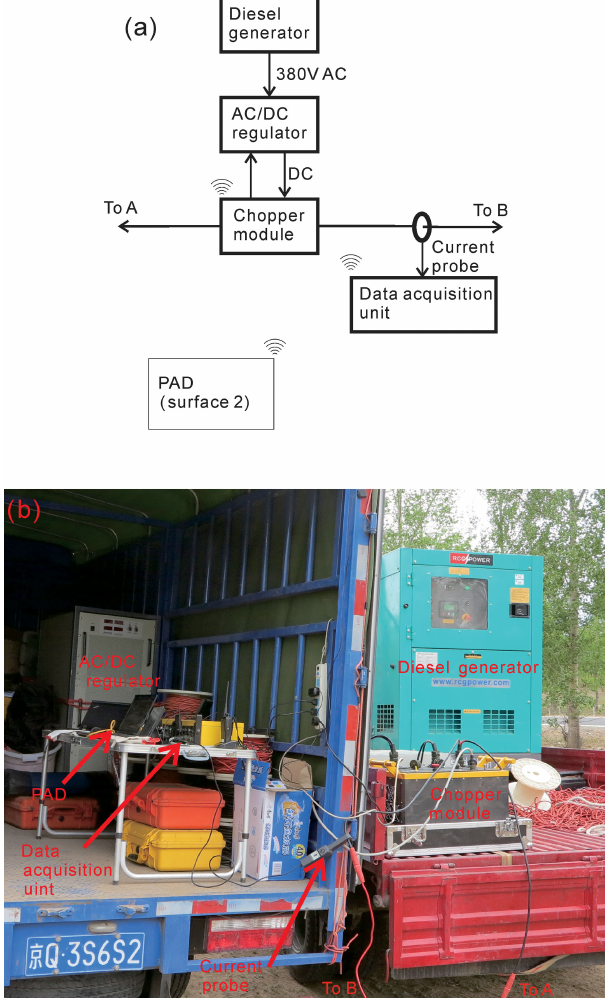
Figure 1. (a) Diagram of multifunction EM transmitter architecture, (b) photograph of the transmitter: diesel generator, AC/DC regu- lator, chopper module, current probe, data acquisition unit, cable, tablet computer